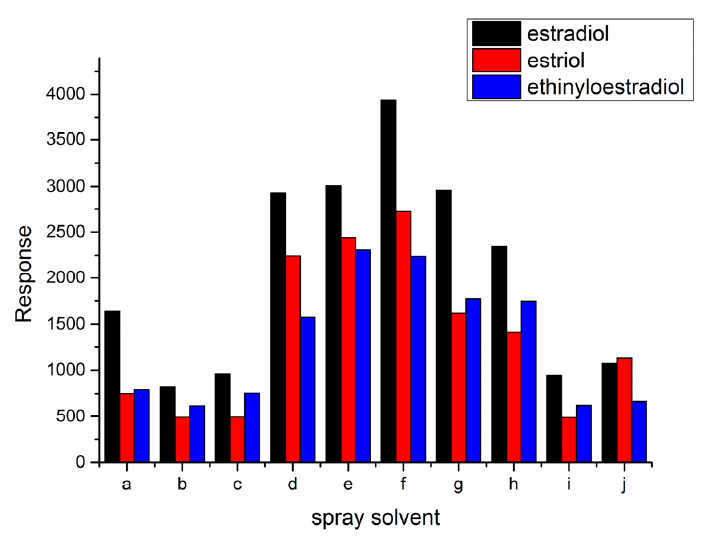
Figure 3. Influence of spray solvents: (a) ACN; (b) MeOH; (c) MeOH/H 2 O = 8/2; (d) ACN/H 2 O = 7/3; (e) ACN/H 2 O = 8/2; (f) ACN/H 2 O = 9/1; (g) ACN/H 2 O = 9.5/0.5; (h) 0.1% formic acid in ACN/H 2 O = 8/2; (i) 0.1% formic acid in ACN; (j) 0.1% formic acid in ACN/H 2 O = 5/5) .